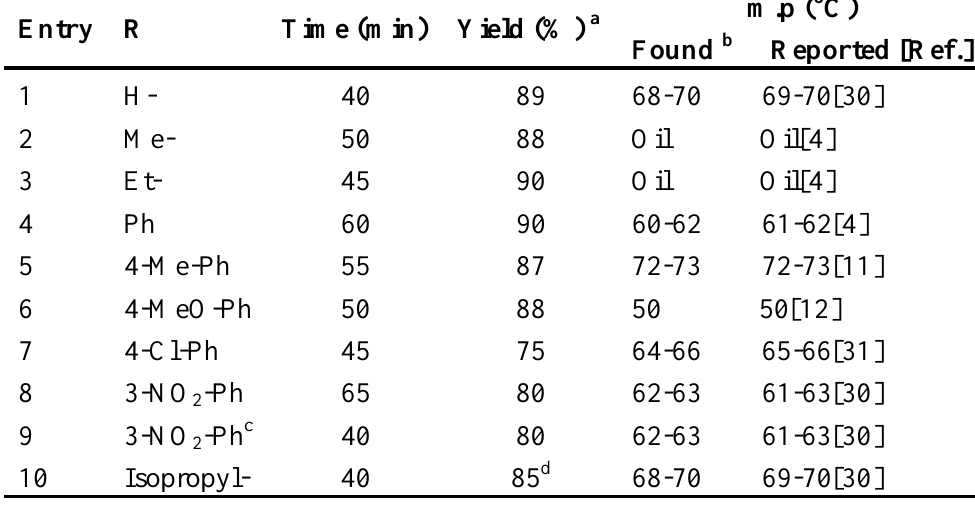
Table 2. Oxidation of Hantzsch 1,4-dihydropyridines in the presence of Cu(C in refluxing acetic